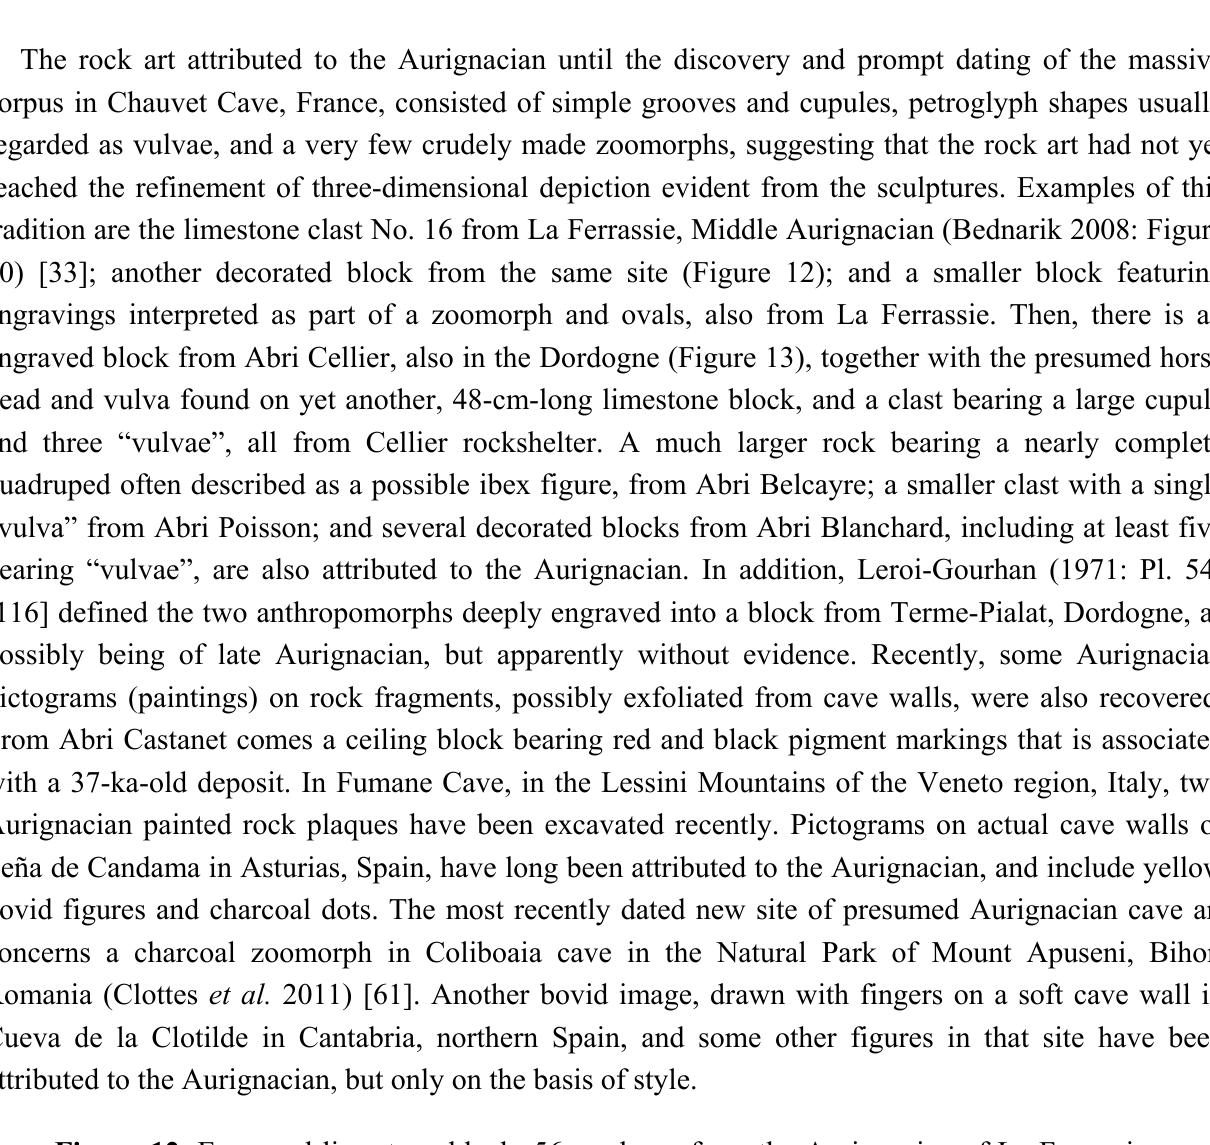
Figure 12. Engraved limestone block, 56 cm long, from the Aurignacian of La Ferrassie, Dordogne,